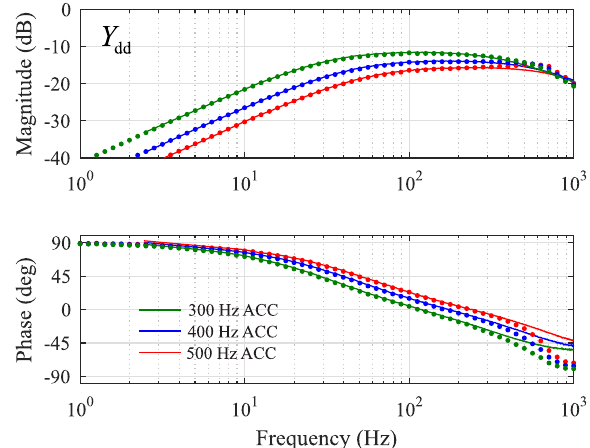
Figure 15. Admittance d-component with different current control crossover frequencies.